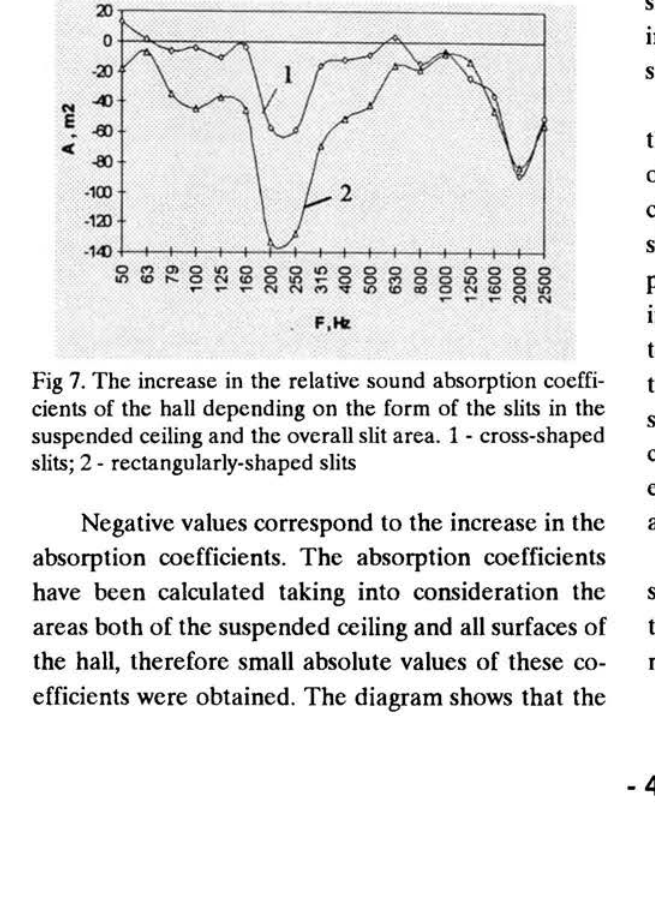
Fig 6. The reduction in the relative early reverberation time of the hall depending on the form of the slits in the suspended ceiling and the overall slit area. 1 - cross-shaped slits; 2- rectangularly-shaped slits Knowing reverberation time values, one may de termine the change in the sound absorption coeffi cients and the overall sound absorption in the hall depending on the shape of the slits and the slit area.